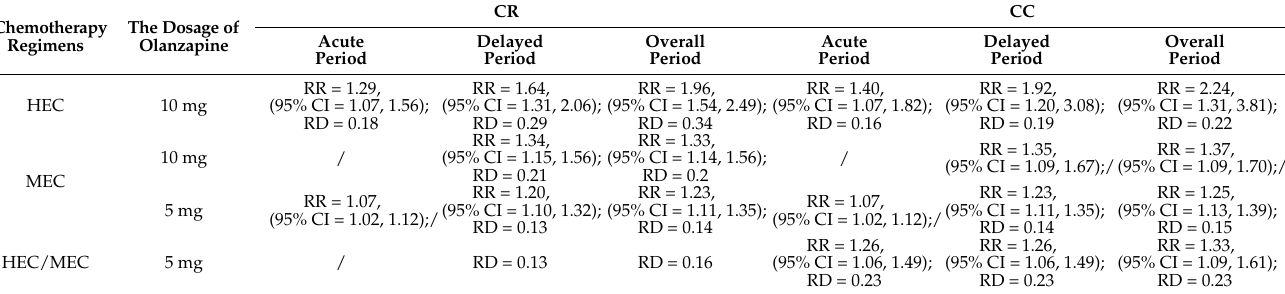
Table 1. CR and CC with different doses of olanzapine for different emetogenic grades.